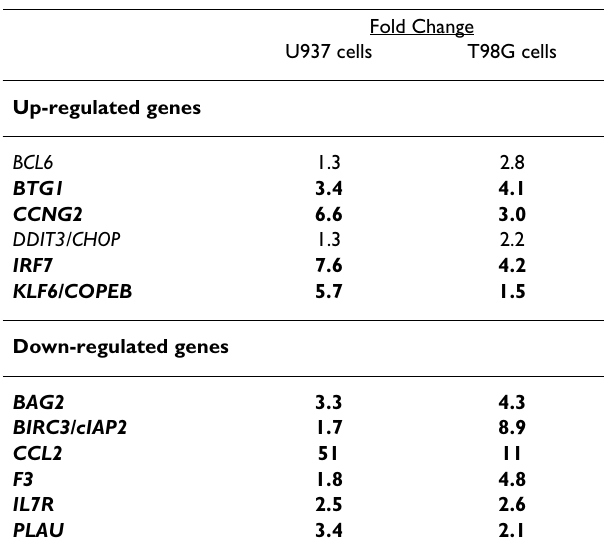
Table 2: Comparison of the effect of PI 3-kinase inhibition on gene expression in U937 and T98G cells. Fold Change U937 cells T98G